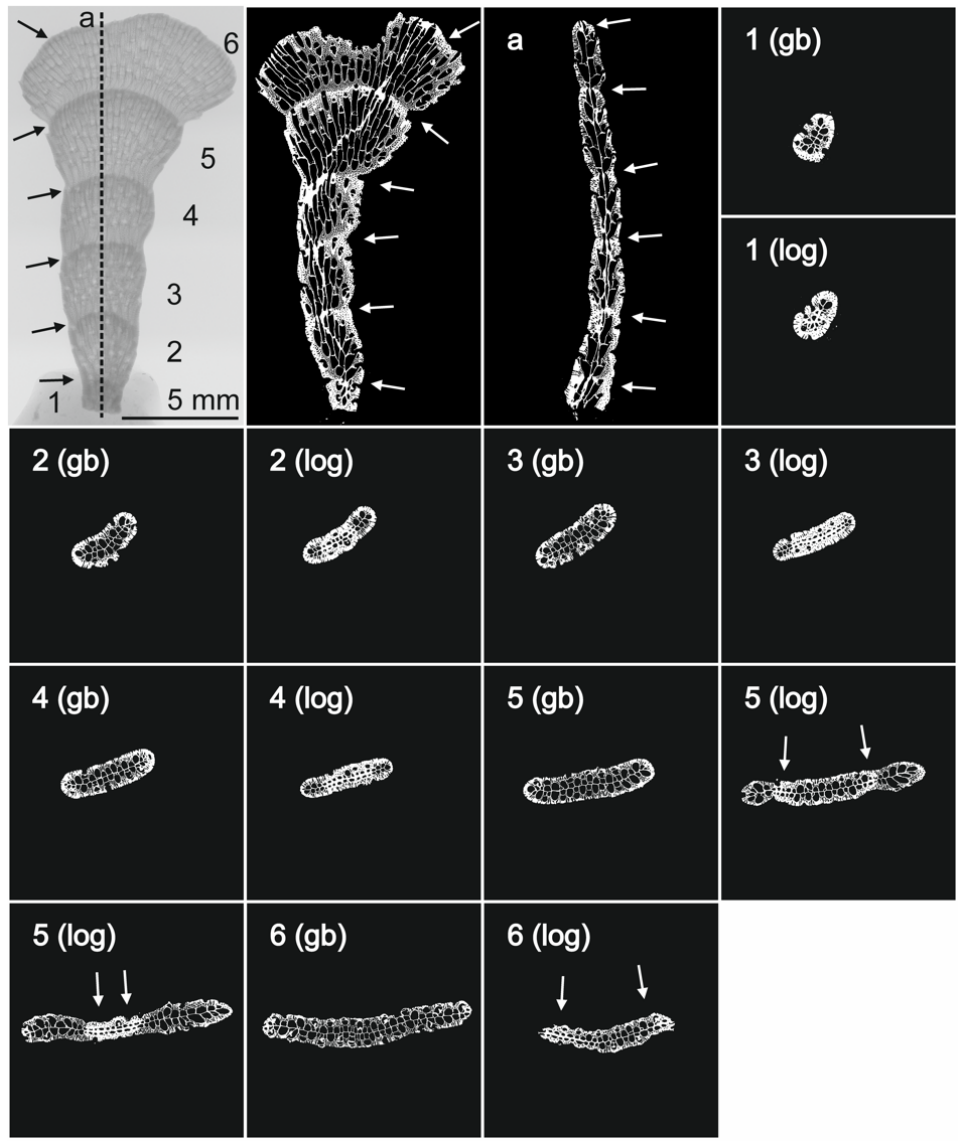
Figure 5. Micro CT images of Cellarinella nutti . Radiographic image of the whole branch (scale bar: 5 mm) showing the growth bands (arrowed) (1–6) and the branch axis ( a ). Frontal and lateral longitudinal sections of the whole branch; 13 transverse sections of the growth bands (gb) ( 1 – 6 ) and growth check lines (gcl) ( 1 – 6 ). Scale bar for micro CT images: 5 mm. Table 2. Growth band number (n gb) and length (gbL) (µm) in Cellarinella nutti and Cellarinella nje- govanae branches. Mean number of growth bands (n band) are reported per colony per species in a decreasing order, from the youngest (n 6) just below the growing edge, to the oldest part of the branch (n 1).